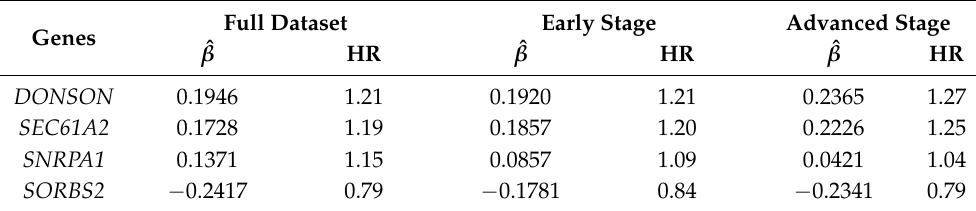
Table 9. List of genes previously selected by both EN and TCox regularizers and corresponding β coefficients obtained when we applied a multivariate Cox survival model with ridge penalization. HR (hazard ratio) gives the effect size of covariates and it is calculated by exp ( β ) . HR = 1, no effect; HR < 1, reduction in the hazard; HR > 1, increase in the